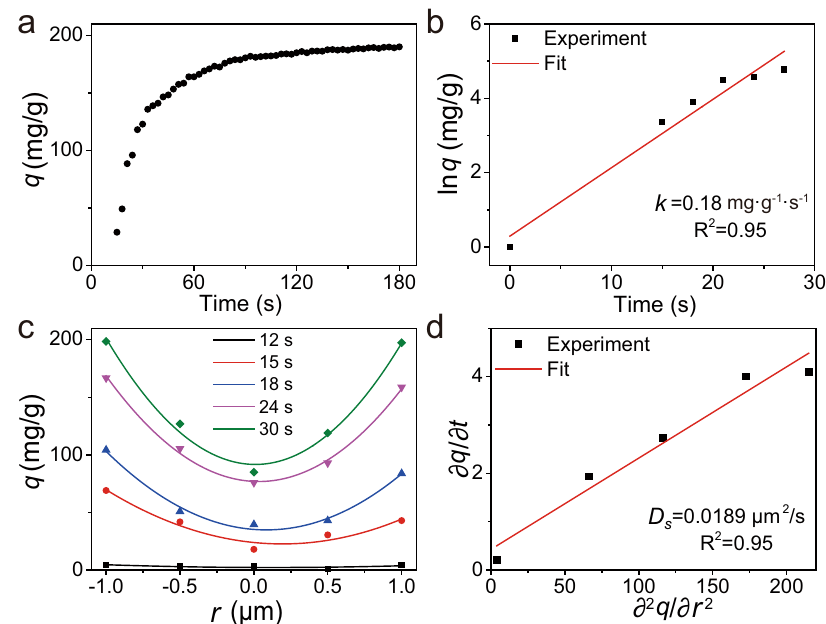
Fig. 3 Kinetic analysis and determination of diffusion coef fi cient. a Adsorption kinetic of gaseous I 2 onto a single ZIF-90 particle. b Pseudo- fi rst order model for adsorption of gaseous I 2 to calculate the apparent rate constant ( k ). c Spatial and temporal variability of I 2 absorption amount distributions in line pro fi les. d Diffusion coef fi cient ( D s ) estimated from Fick ’ s second